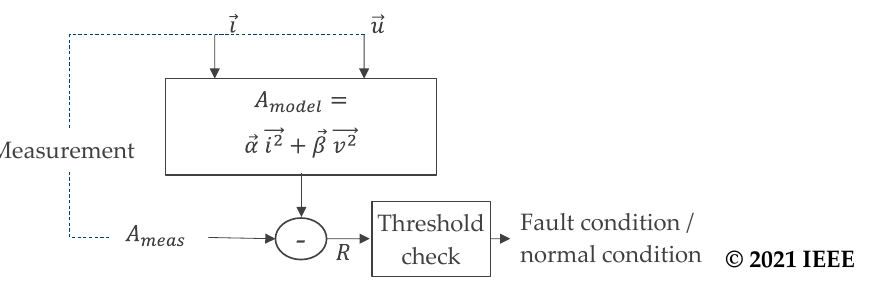
Figure 8. Model-based diagnostic system [30].